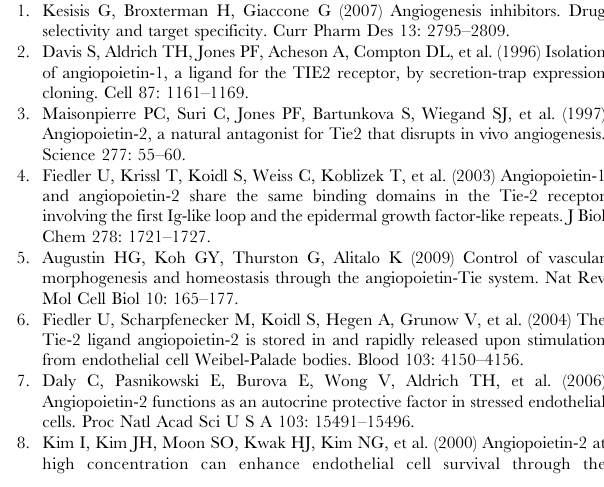
Figure S1 Binding of Ang-1 and Ang-2 to LC06 and LC08 measured by SPR. SPR data confirm similar high affinities of all tested antibodies targeting human Ang-2. LC08 in contrast to LC06 shows also significant binding towards human Ang-1. Two independent experiments were performed to confirm the results. Figure S2 Setup of surface plasmon resonance. The antibody of interest (LC06 or LC08) was immobilized on the surface of a C1 SPR Chip. Fixed concentrations of hAng2 or hAng1 were pre- incubated together with increasing concentrations of the corre- sponding antibody and injected onto the flowcells. Figure S3 Effect of LC06 and LC08 treatment on body weight of SCID beige mice bearing KPL-4 and Colo205 tumors. No significant toxicity was observed as demonstrated by the changes in body weights for SCID beige mice bearing KPL-4 (A) and Colo205 (B) tumors (n= 10). Arrows indicate start of treatment. The results were confirmed in two additional independent experiments. Figure S4 Staining of desmin-positive and NG2-positive vessels. Representative images (20x) of vehicle, LC06 or LC08 treatment are shown. Association of desmin- (A) and NG2 (B) positive cells (green) with tumor vessels (red) is significantly increased after LC06 and LC08 treatment of Colo205 tumors. Colocalized staining (yellow) of pericytes (green) and endothelial cells (red) can be detected. Scale bar: 500 m m. Figure S5 Staining of perfused vessels. Representative images (20x) of vehicle, LC06 or LC08 treatment are shown. Perfused vessels (red; i.v. injection of lectin-TRITC) appear yellow as they are superimposed on the CD34 staining (green). While treatment with LC06 and LC08 reduced microvessel density in Colo205 tumors it increased the percentage of lectin perfused vessels (yellow) compared to the total amount of remaining vessels (green).